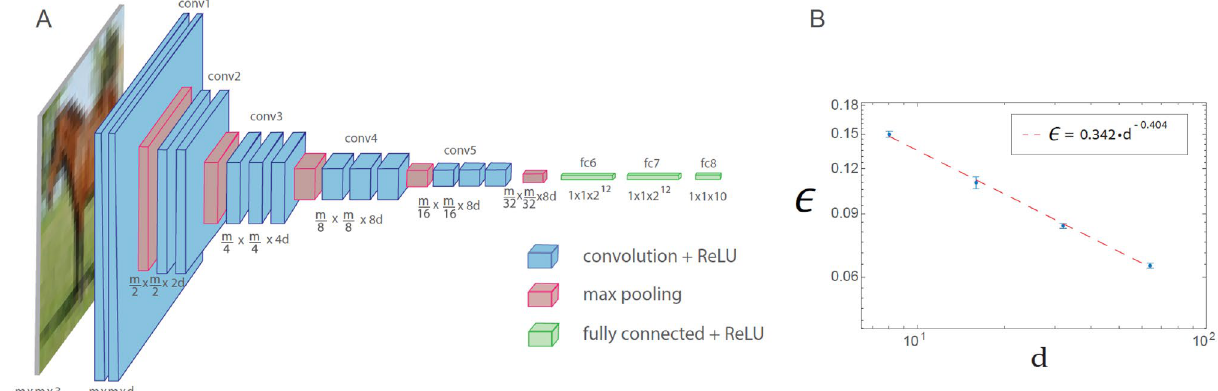
Figure 2. Learning in generalized VGG-16 architecture. ( A ) Generalized VGG-16 architecture consisting of 16 n − 1 layers, where the number of filters in the n th convolution set is d · 2 ( n ≤ 4 ) and the square-root of the size n − 1 ) of the filter is m · 2 − ( ( n ≤ 5 ) , where m × m × 3 is the size of each input ( d = 64 in the original VGG-16 architecture). ( B ) The test error, ǫ , as a function of d on a log–log scale, for the CIFAR-10 database ( m = 32 ), indicating a power-law scaling with exponent ρ ∼ 0.4 , Eq. (3) (Supplementary Information). The activation function of the nodes is